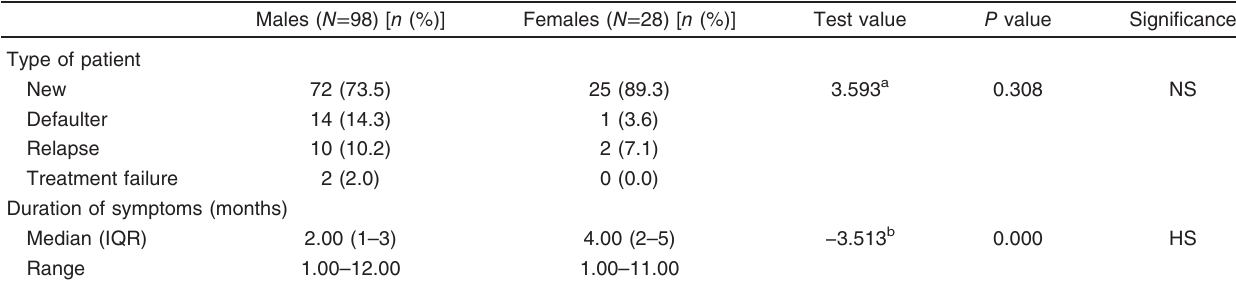
Table 2 Descriptive data regarding type of the patient and duration of symptoms Males ( N = 98) [ n